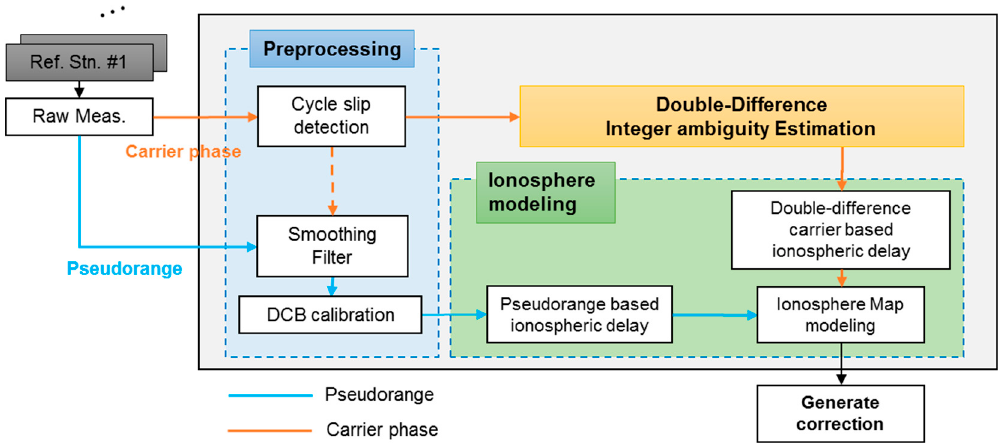
Figure 2. Ionospheric modeling procedure. DCB: differential code bias.